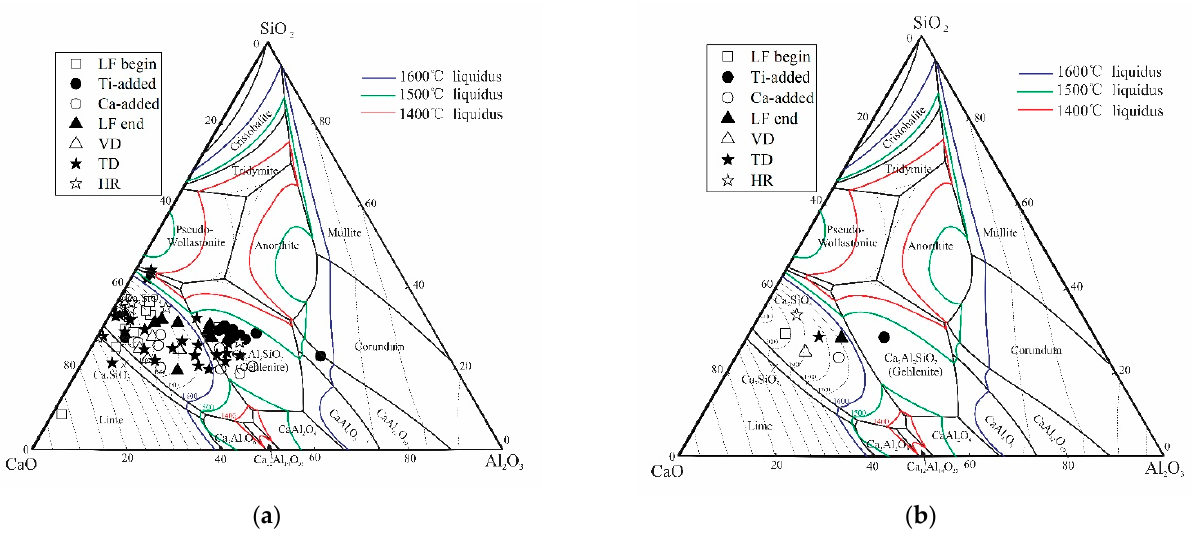
Figure 10. CaO-Al 2 O 3 -SiO 2 ternary phase diagrams.( a ) experimental data, ( b ) average data. The CaO-Al 2 O 3 -SiO 2 and CaO-SiO 2 inclusions’ compositions at different stages were projected into ternary phase diagrams of CaO-Al 2 O 3 -SiO 2 , as shown in Figure 10. Since the